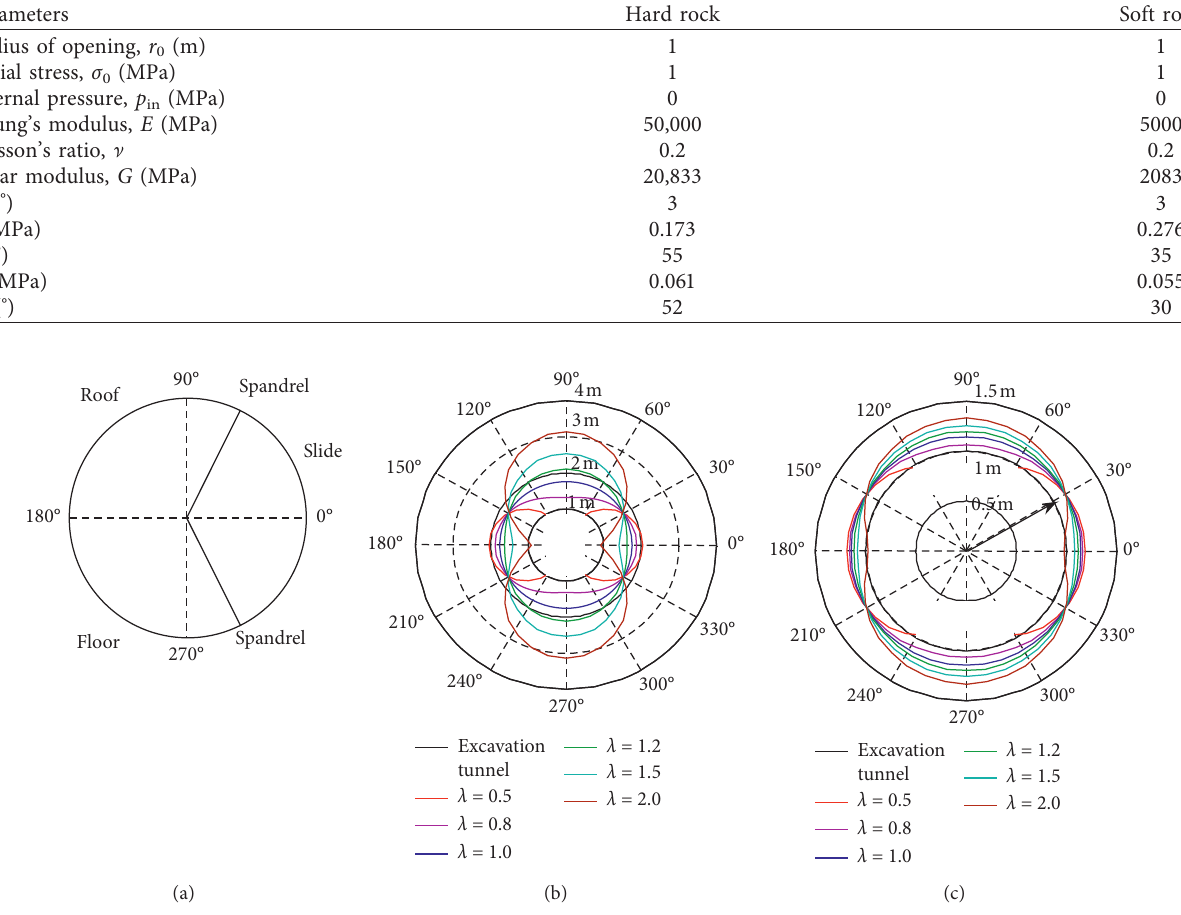
Figure 3: Comparisons between displacement of plastic zone in this paper and Park’s solution. (a) The solution with soft rock parameters. (b) The solution with hard rock parameters. Table 1: Geometrical and physical parameters of a circular opening [5].